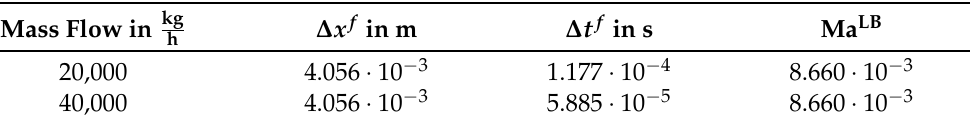
Table 3. Lattice Boltzmann method (LBM) discretization parameters for the both investigated mass flows.